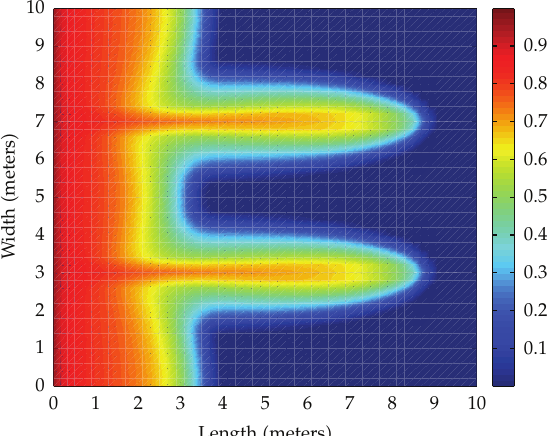
Figure 3: Water saturation profile at 0.35 PVI by the conventional method: Example 1.